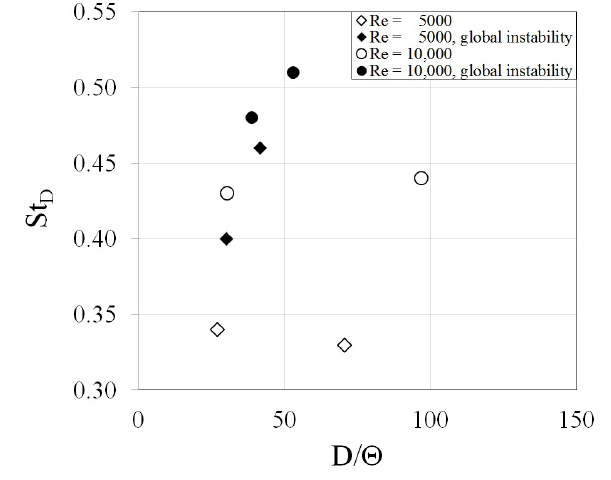
Figure 17. Non-dimensional frequency as a function of the D / θ parameter.